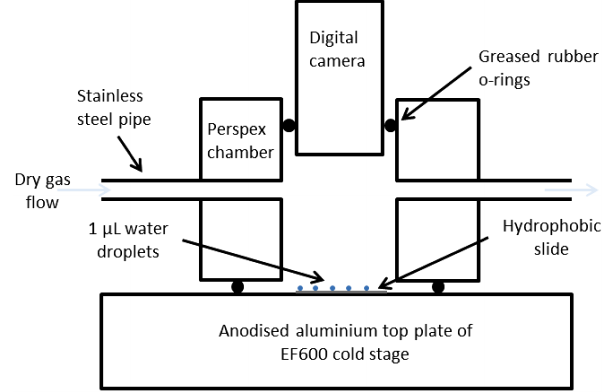
Figure 1. Diagram illustrating the key components of the µL-NIPI.